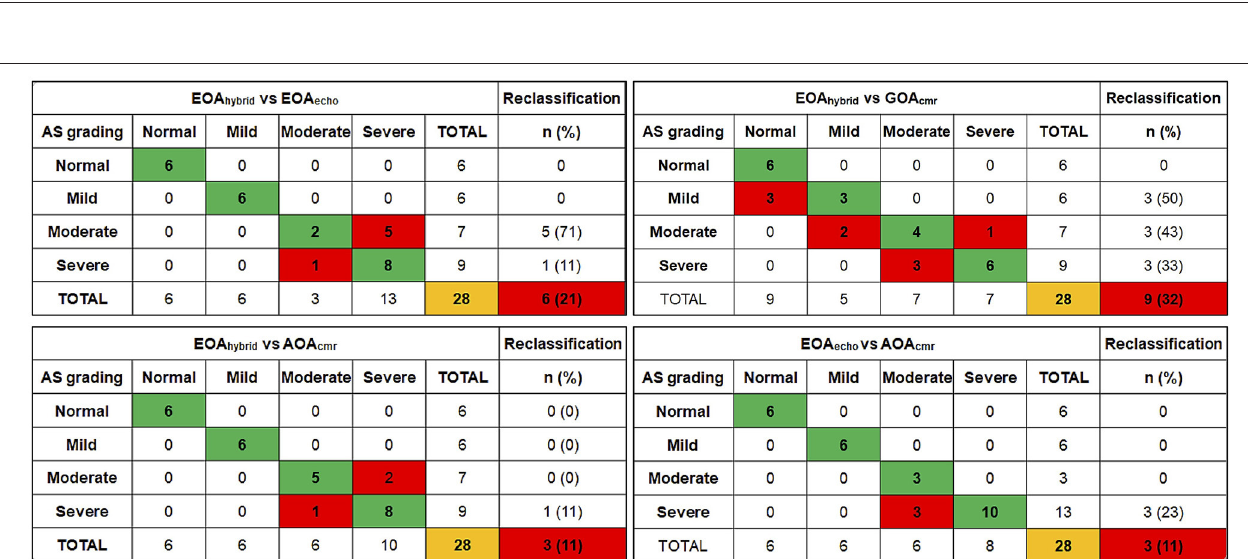
FIGURE 6 | Reclassification analysis of aortic stenosis severity according to different imaging methods. This plot allows describing the number of upward or downward reclassification (red boxes) of aortic stenosis severity according to different methods.